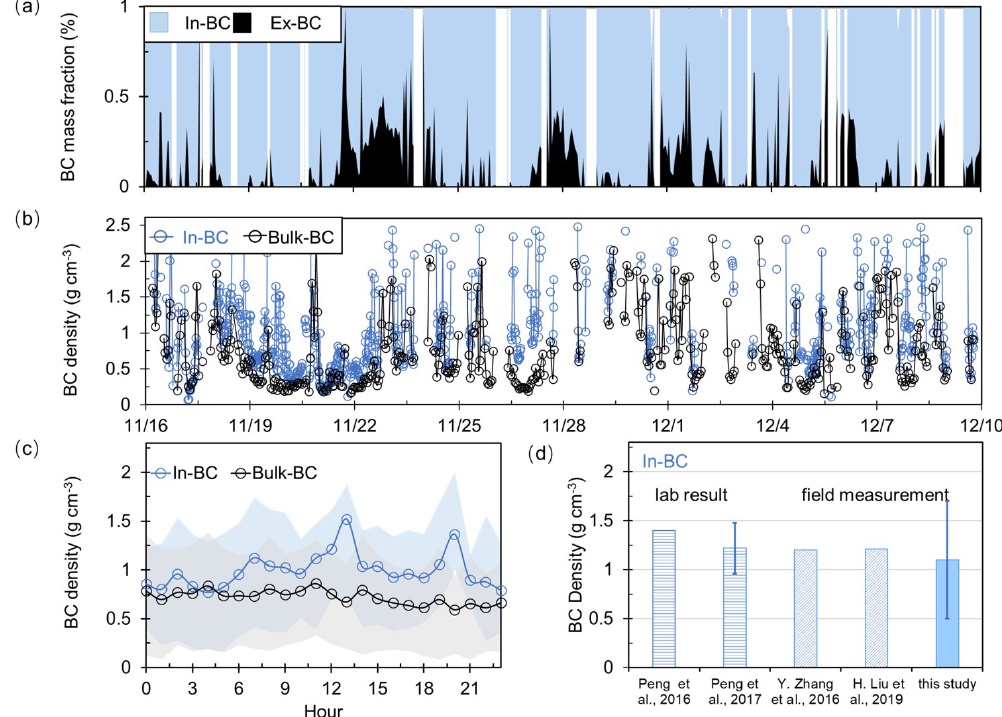
Figure 4. (a) Time series of the mass fraction of the retrieved internal and external mixed BC. (b) Time series of the retrieved density of the bulk and internal mixed BC (In-BC). (c) Diurnal variation in the retrieved density of bulk and In-BC. (d) Comparison of the results of the derived In-BC density in this study with that reported in the